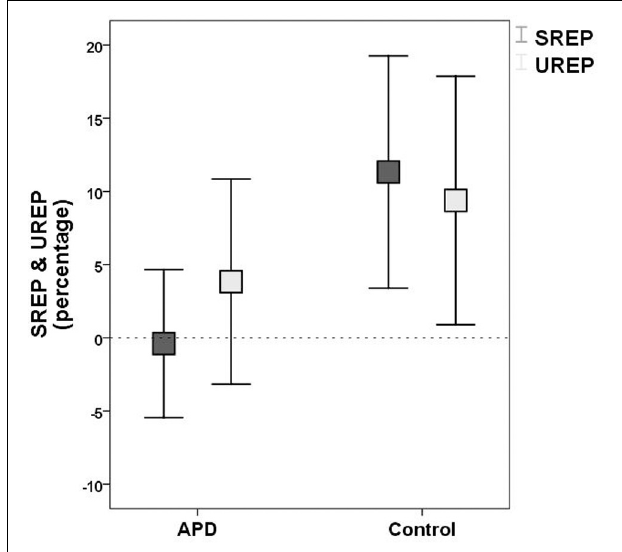
FIGURE 2 | Means and 95% error bars for SREP (dark rectangles) and UREP (bright rectangles) scores for APD and control group respectively. SREP score units are percentages, describing the synchronized rhythm effect on speech in noise recognition. UREP score units are percentages, describing the un-synchronized rhythm effect on speech in noise recognition. Squares represent means. Error bars represent 95% confidence intervals. Dash line (y = 0) represents ‘no effect,’ i.e., recognition not affected by rhythm (see WRRC scoring). SREP, synchronized rhythm effect percentage; UREP, un-synchronized rhythm effect